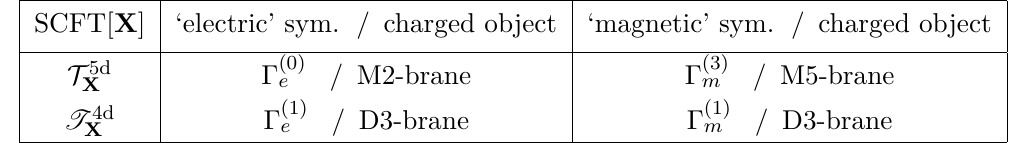
Table 2 . The group f ⊂ H 2 ( L 5 ( X ) , Z ) , interpreted as a q -form symmetry group Γ ( q ) .